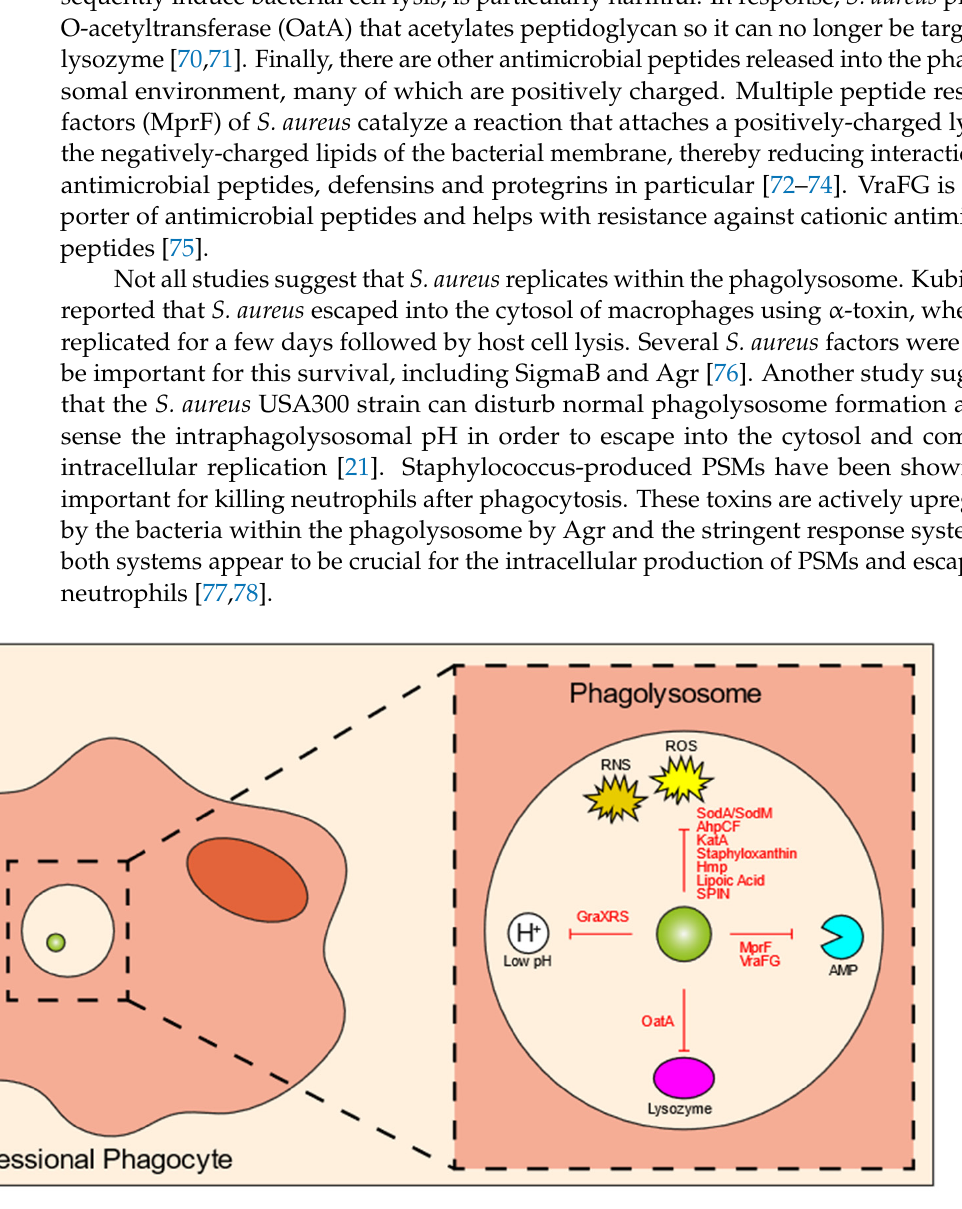
Figure 2. S. aureus intraphagolysosomal evasion strategies. Once inside the phagolysosome of professional phagocytes, the bacteria get exposed to various antimicrobial molecules designed to kill the bacteria. Co-evolution of host and pathogen has led to a variety of evasion molecules produced by S. aureus to counteract these phagolysosomal killing mechanisms. These mechanisms include evasion molecules against ROS and RNS, AMPs, lysozyme, and acidic pH. Abbreviations: ROS, reactive oxygen species; RNS, reactive nitrogen species; Sod, superoxide dismutase; AhpCF, alkyl hydroperoxidase reductase; KatA, catalase; Hmp, flavohemoglobin; SPIN, staphylococcal peroxidase inhibitor; AMP, antimicrobial peptide; MprF, multiple peptide resistance factor; OatA, O ‐ acetyl ‐ transferase.